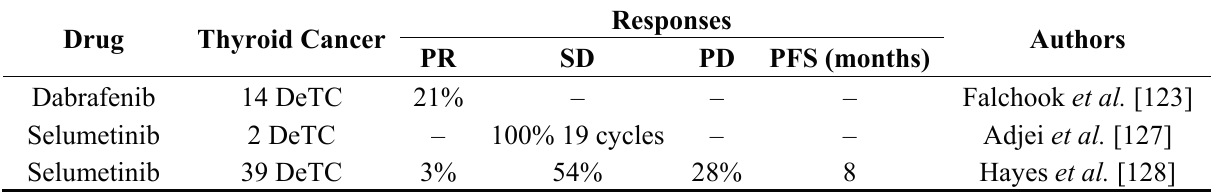
Table 4. Clinical trials with BRAF inhibitors in patients with thyroid